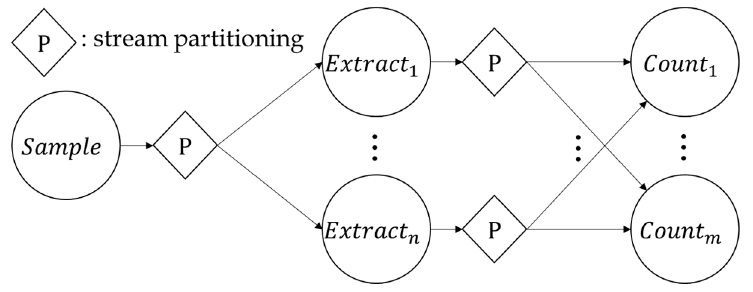
Figure 1. Example of a distributed stream processing engine (DSPE) application: counting Twitter hashtags.